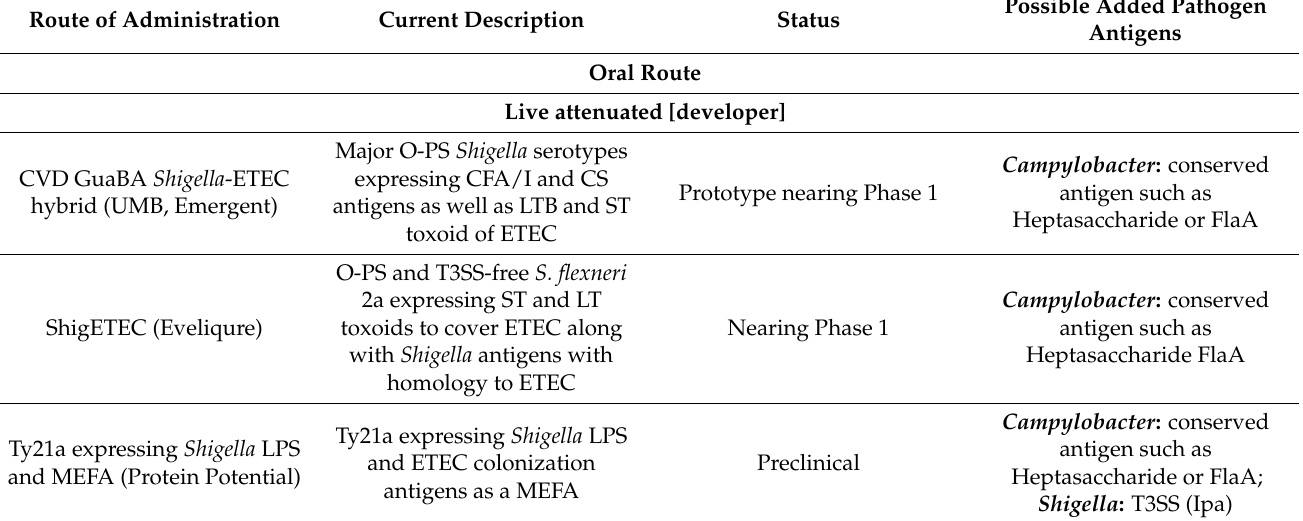
Table 4. Multi-pathogen vaccine